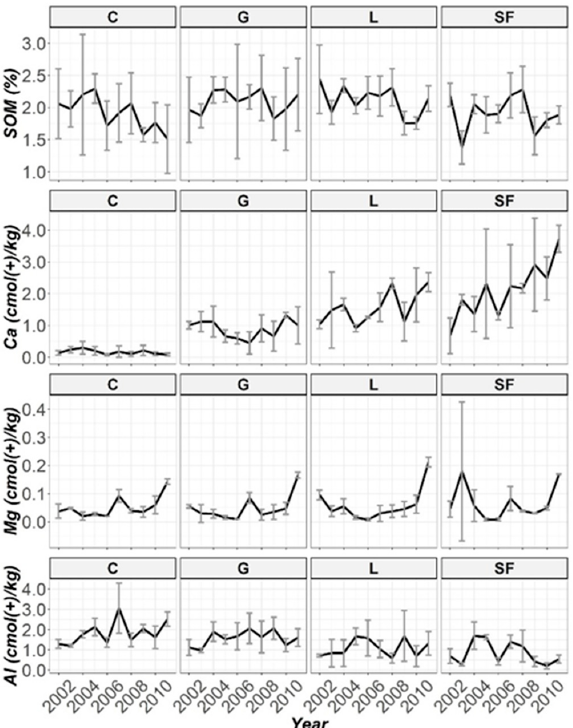
Figure 3. Temporal evolution of SOM, Ca, Mg and Al in the Ap1 horizon throughout the ten years of soil monitoring (2002–2011).